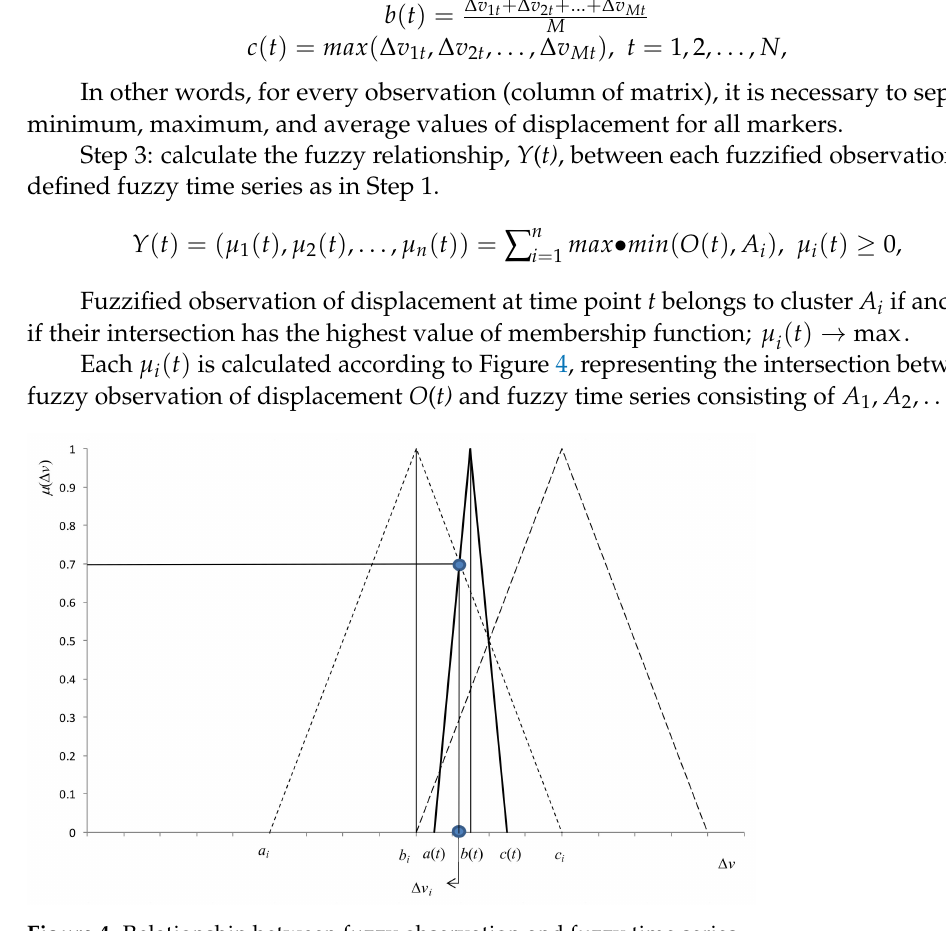
Figure 4. Relationship between fuzzy observation and fuzzy time